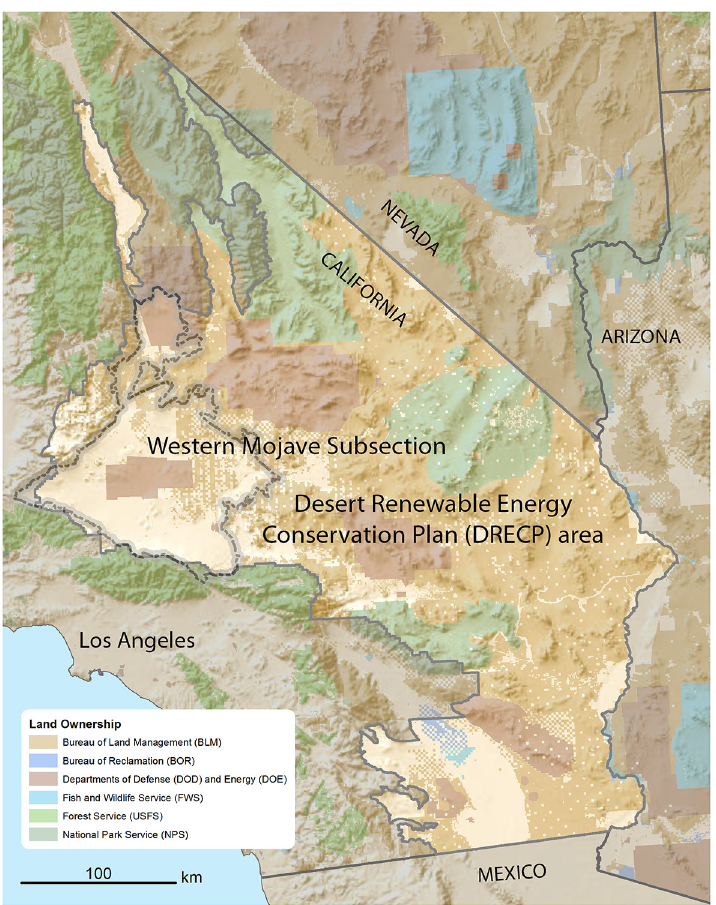
Fig 1. Location map. The Western Mojave DRECP study area (California Ecological Subsection 322Ag: High Desert Plains and Hills [30].The remainder of the methods section is organized as follows: a brief explanation of the Zonation conservation software package [24, 25] precedes further detail describing options of the Mojavset offsetting tool. This is followed by a description of our case study site and offsetting decisions, the creation of our set of hypothetical USSED sites, the spatial data describing conservation features, and a description of the two offset analyses analyzed in the case study.